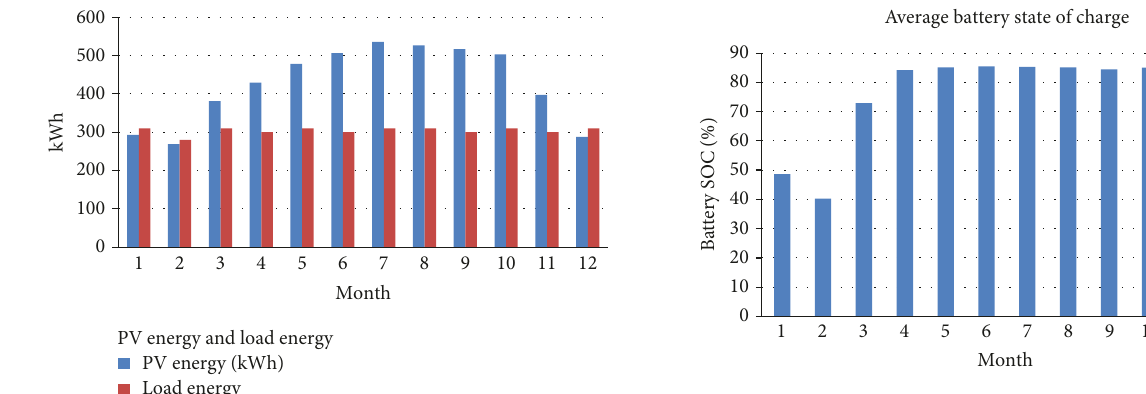
Figure 8: The monthly state of charge of battery block (48/19.2 kWh).